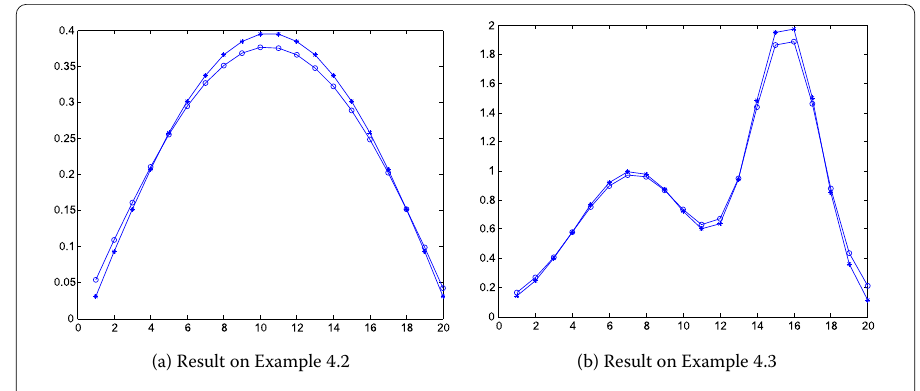
Figure 2 Numerical results on Examples 4.2 and 4.3: ‘ ∗ ’ is the true solution and ‘ ◦ ’ denotes the approximate